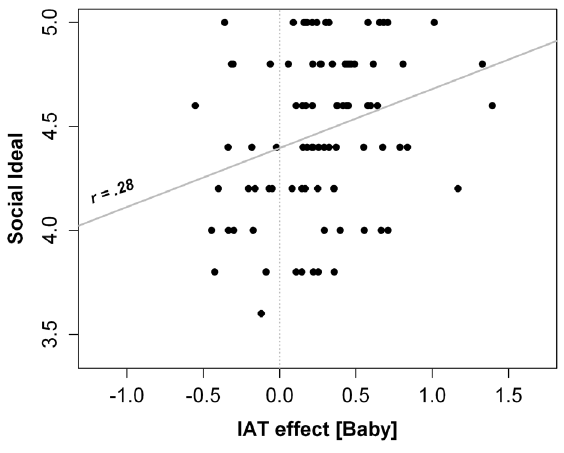
Figure 2. Scatter plot of the relation between the infant faces IAT effect and Social ideal style. Note. The solid line represents the linear relation model. The dashed line represents the neutral D score